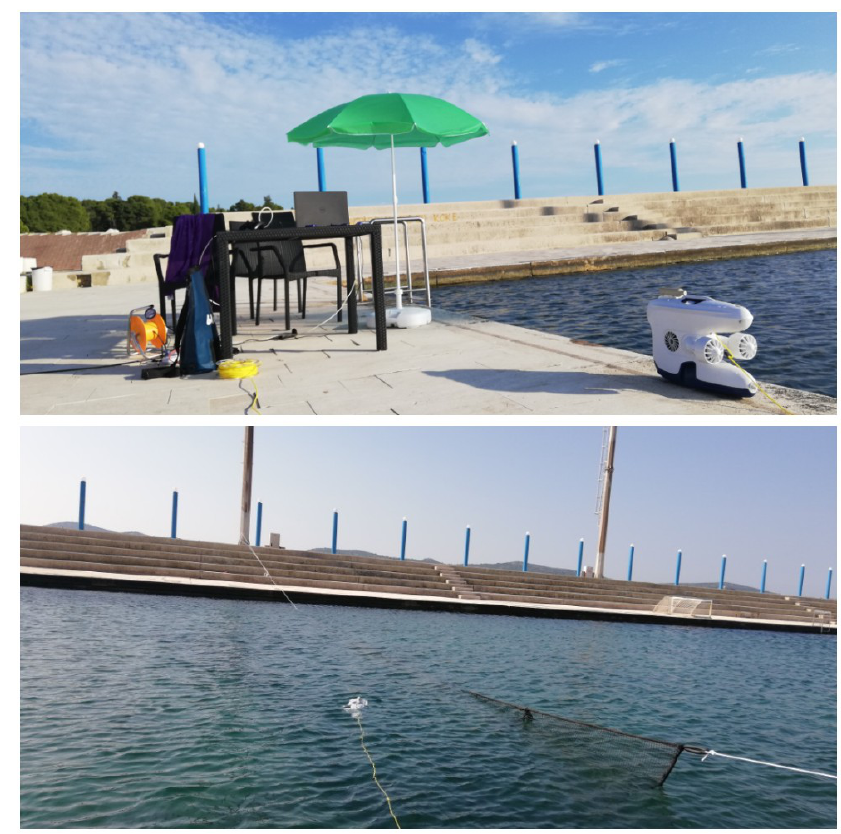
Figure 16. Field trial view before